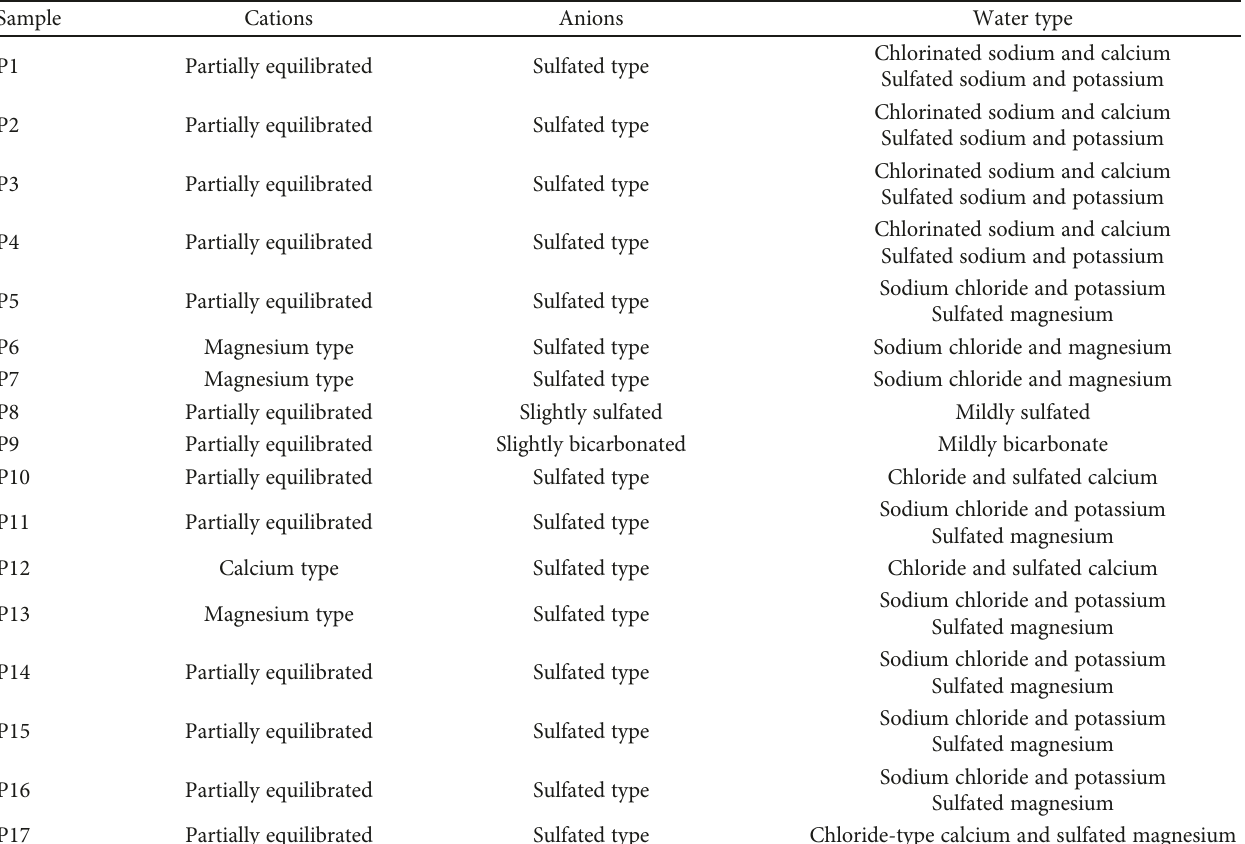
Table 5: Chemical classi fi cation of waters of the Puracé-La Mina sector, according to cations, anions, and water type.